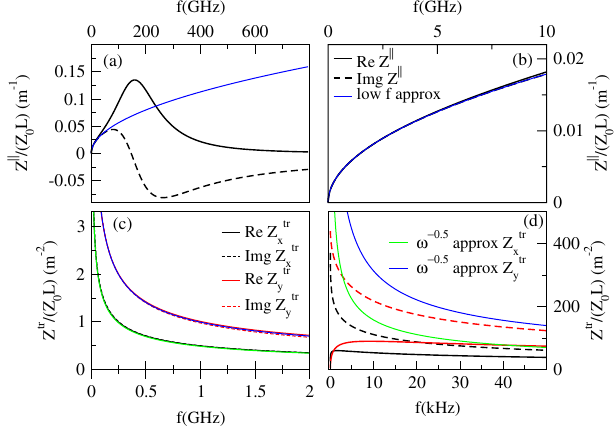
FIG. 1. Impedances of a parallel-plane iron pipe, (cid:8) iron ¼ 0 : 5 (cid:3) 10 7 ð (cid:3)m Þ (cid:1) 1 with b ¼ 0 : 02 m . (a) and (b) Real (black continuous) and imaginary (black dashed) longitudinal imped- ance, Eq. (19). The low frequency approximation (blue) / Eq. (35), is valid up to 10 GHz. (c) and (d) Real and imaginary part of the horizontal (black continuous and black dashed) and the vertical (red continuous and red dashed) impedances, Eqs. (23) and (21). Equation (36) (green) and Eq. (37) (blue) are valid approximations in the interval range 1 MHz–2 GHz.